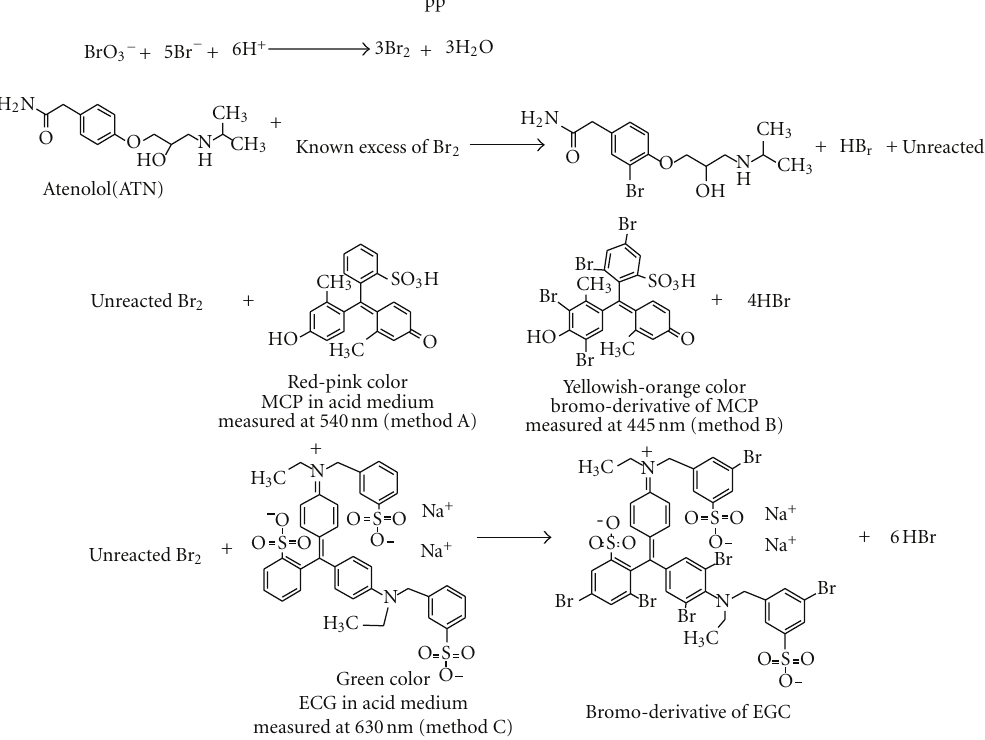
Figure 2: Tentative reaction scheme for the proposed